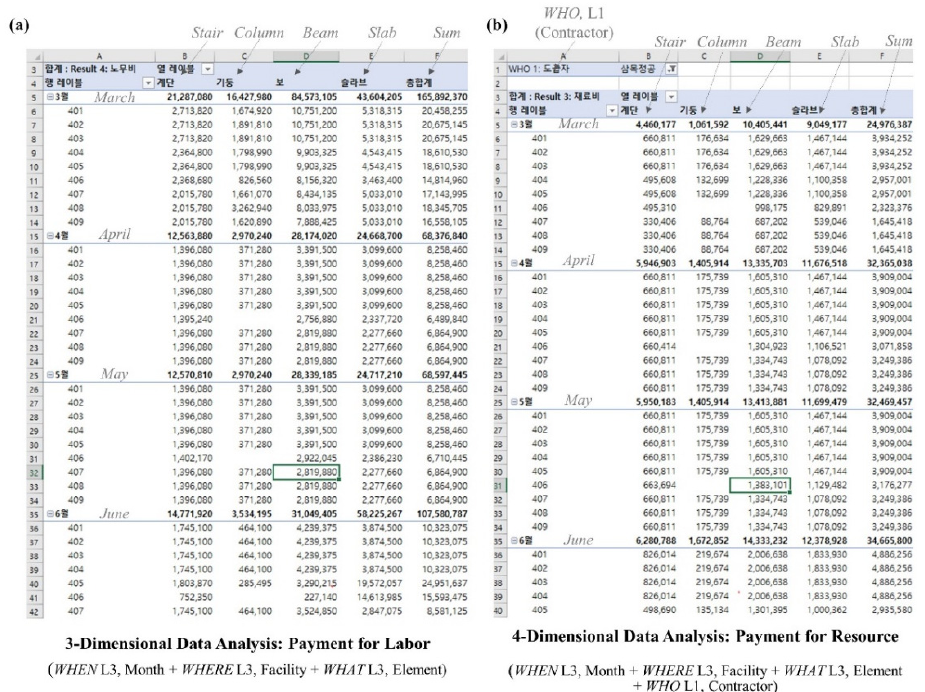
Figure 10. Periodic Payment Report Generated by the Implemented Algorithm, ( a ) Payment for Labor, ( b ) Payment for Resource in the Case Study Project.